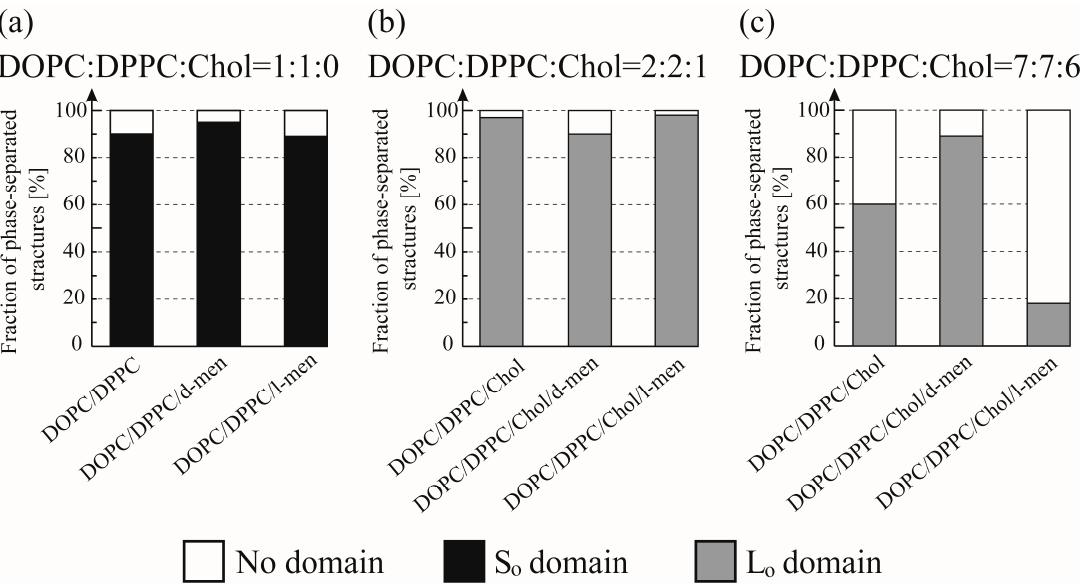
Figure 4. Fraction of phase-separated structures in DOPC/DPPC/Chol/menthol systems at room temperature. We fixed DOPC:DPPC:Chol = 1:1:0 in ( a ), DOPC:DPPC:Chol = 2:2:1 in ( b ), and DOPC:DPPC:Chol = 7:7:6 in ( c ). The mole fraction of menthol is 10%. White, black, and grey bars indicate no domain (homogeneous phase), S o domain formation, and L o domain formation, respectively. Number of liposomes counted = 55.